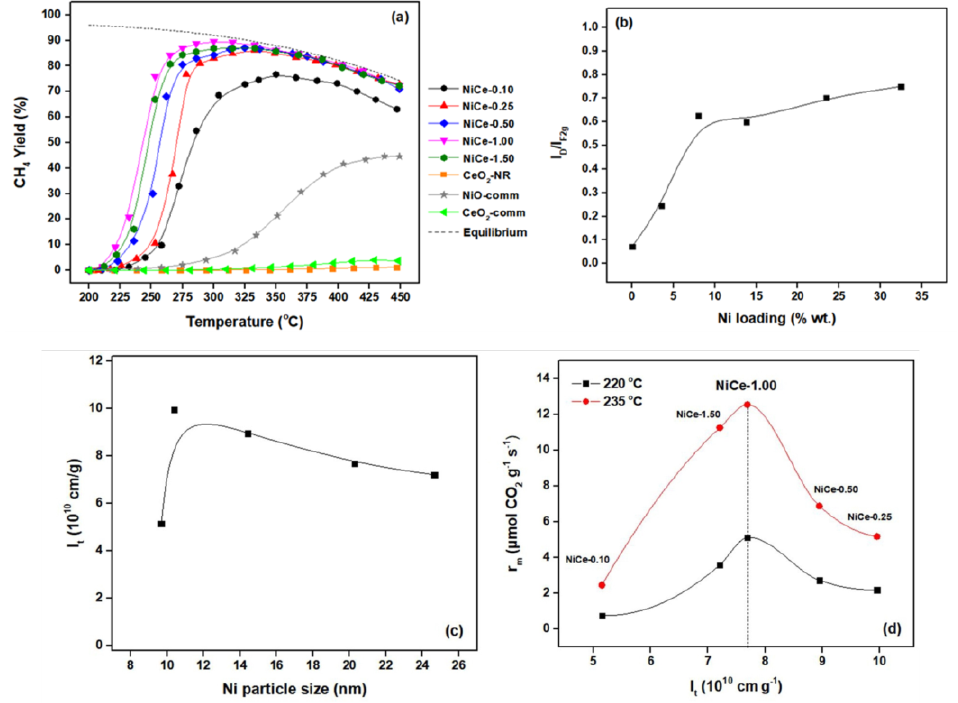
Figure 29. Methane yield ( a ), oxygen vacancy concentration ( b ), Ni particle size effect on the total nickel-ceria perimeter ( c , d ) relationship between the mass-normalized reaction rate and Ni-CeO 2 nickel-ceria perimeter ( c ) and ( d ) relationship between the mass-normalized reaction rate and Ni- perimeter. Reproduced with permission from Ref. [248]. Copyright© 2021, CeO 2 perimeter. Reproduced with permission from Ref. [248]. Copyright© 2021, Elsevier.